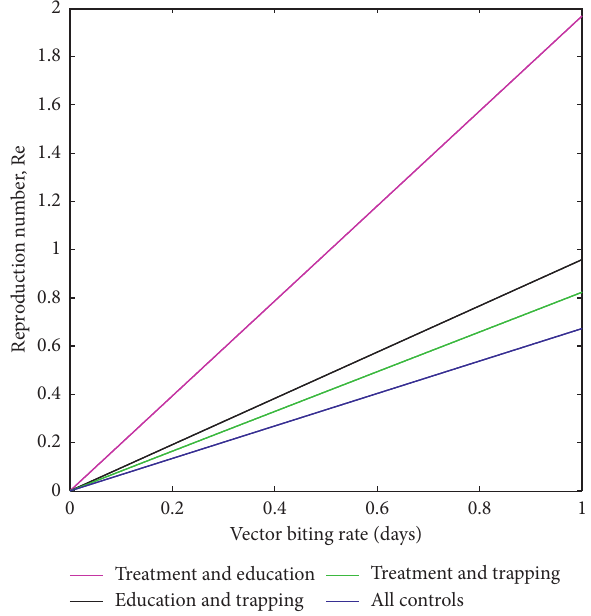
Figure 11: Effects of combining interventions on effective re- production number with respect to vector biting